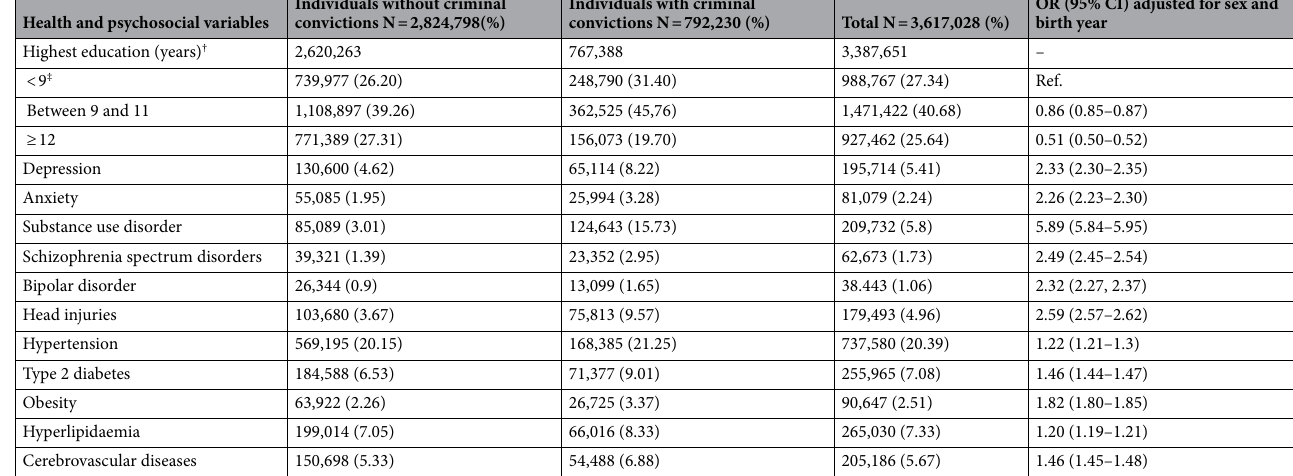
Table 2. Descriptive characteristics of the cohort with regards to the mental and physical health disorders and educational attainment, and the associations with the criminal background (criminal convictions), presented as odds ratios (OR) with 95% confidence intervals (CI), adjusted for sex and birth year. † Highest education: there are 229,377 missing values: 204,535 missing values for Individuals without criminal convictions, 24,842 missing values for individuals with criminal convictions. ‡ References